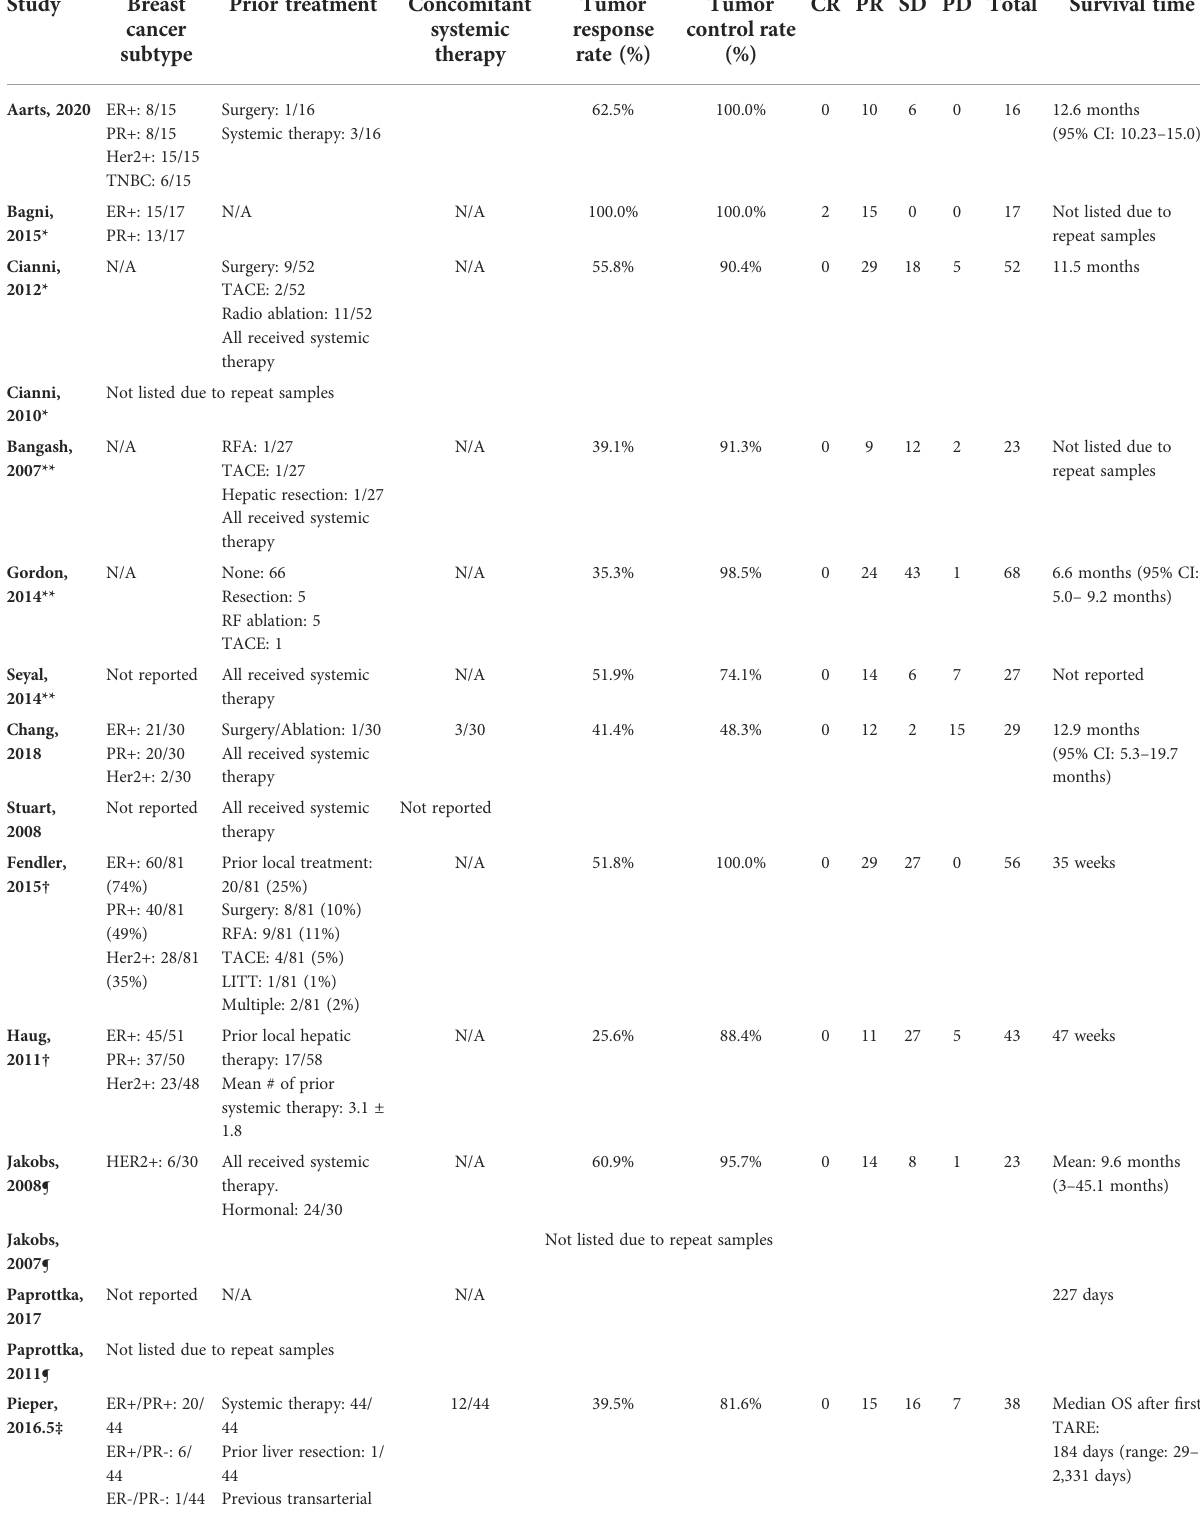
TABLE 2 Baseline characteristics of studies